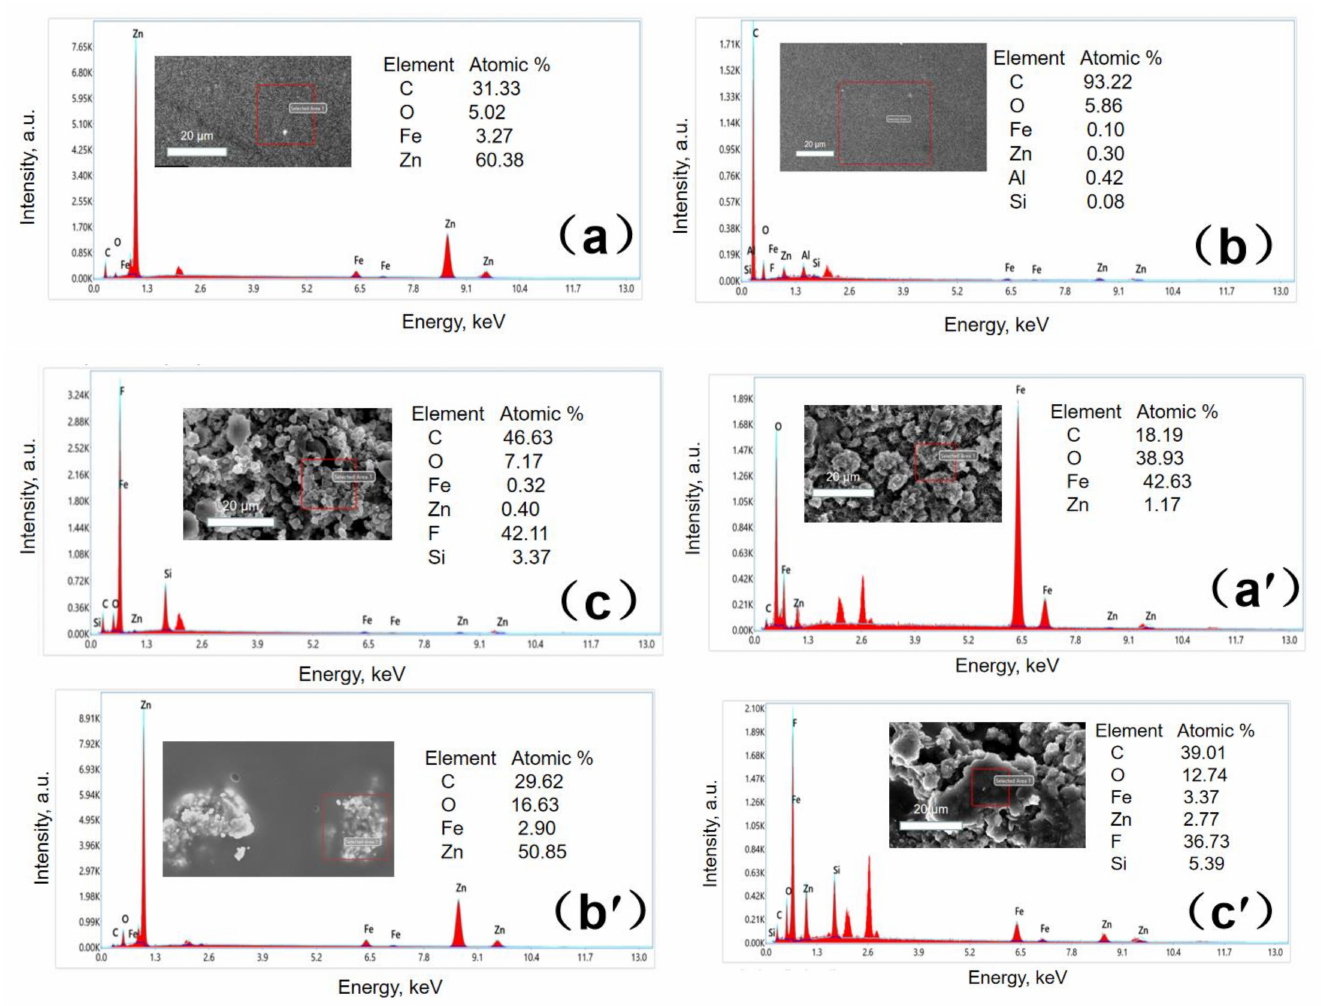
Figure 8. EDS line scanning spectrum of specimens: ( a , a (cid:48) ) for specimen #1 before/after corrosion; ( b , b (cid:48) ) for specimen #2 before/after corrosion; ( c , c (cid:48) ) for specimen #3 before/after corrosion.